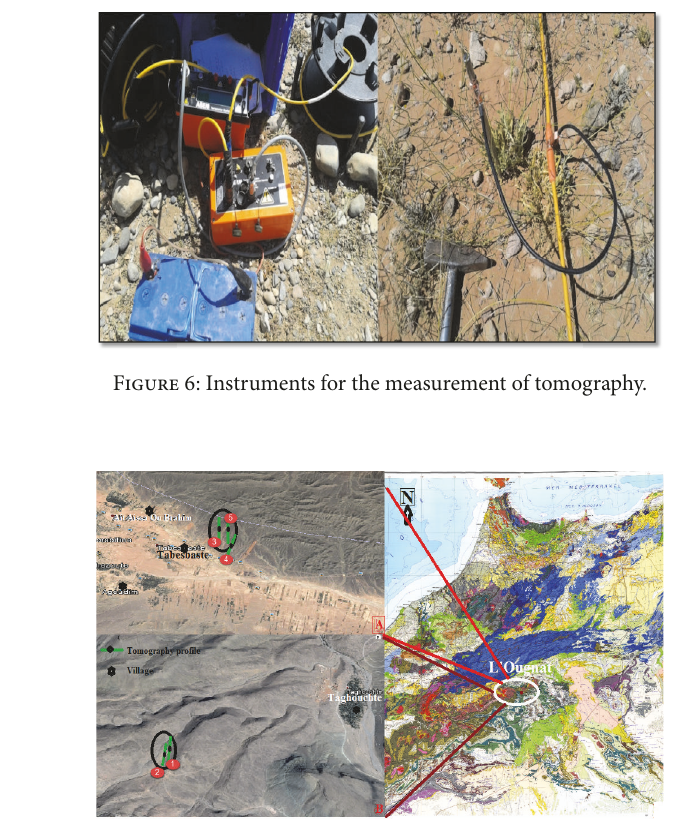
Figure 7: Location of the study area: A, Tabesbaste area; B, Taroucht area.